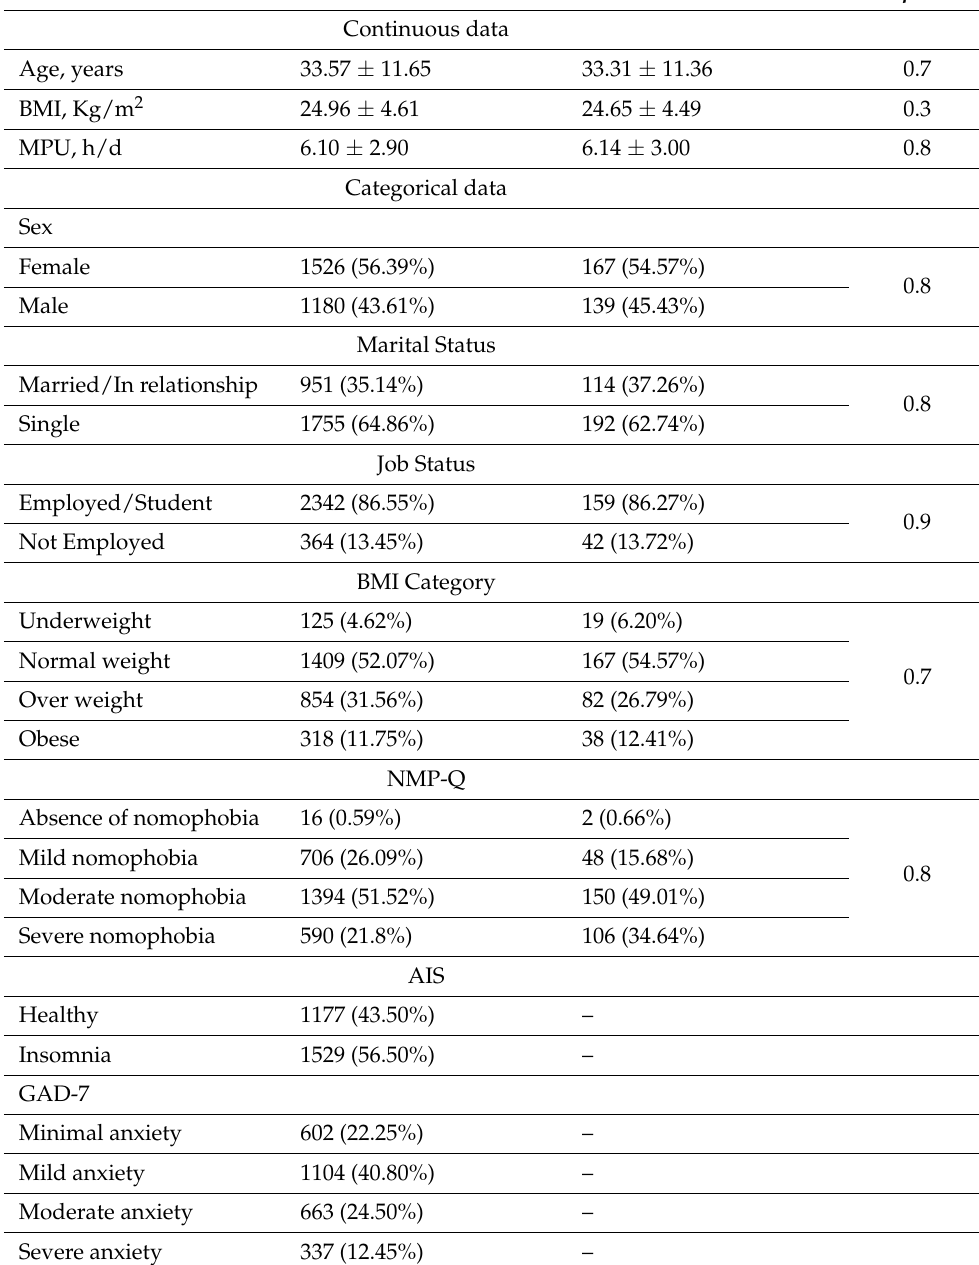
Table 1. Descriptive statistics of study